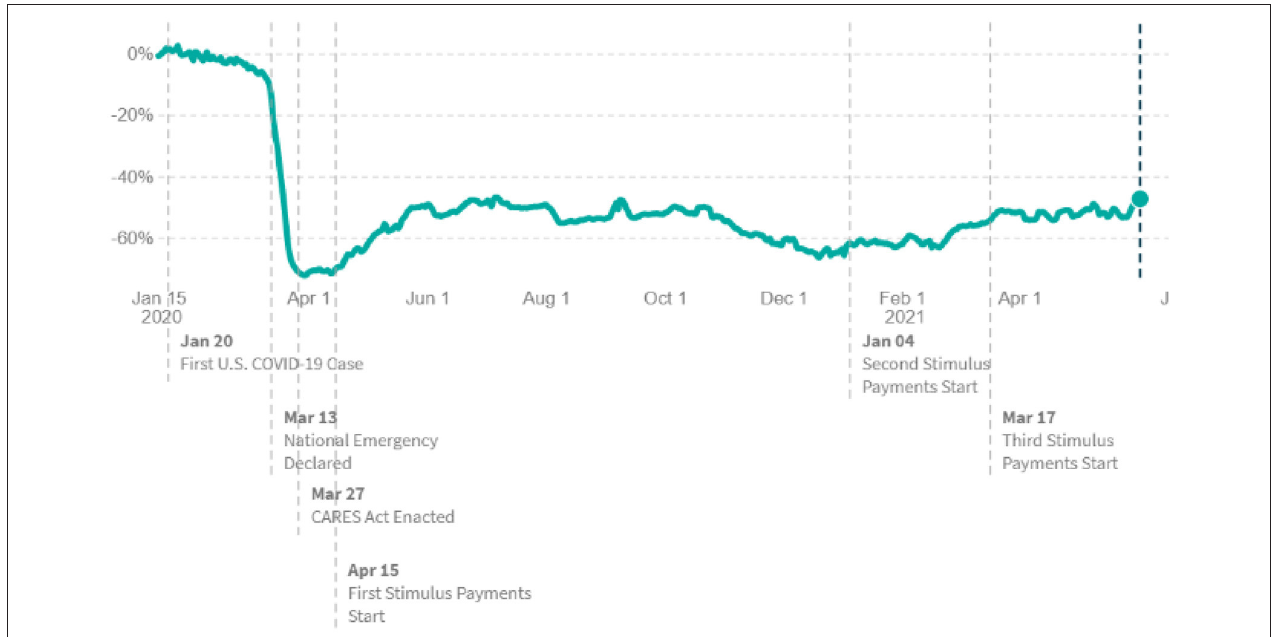
FIGURE 1 | Small businesses net revenues: leisure and hospitality sector (national level, % of change). Source: https://tracktherecovery.org/ proposed by Chetty et al.